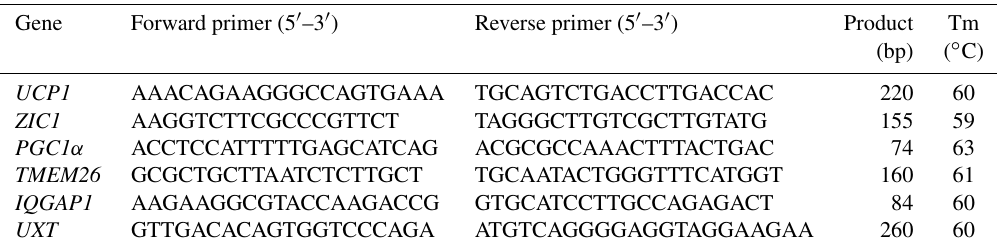
Table 1. Details of the primers used for the RT-qPCR assay.